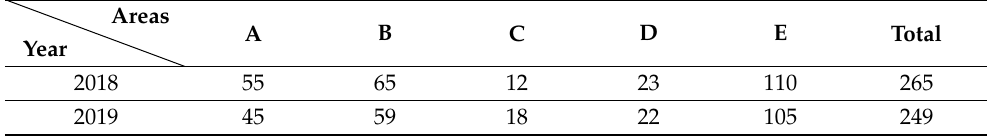
Table 1. Number of stations for water collection per area in the 2018 and 2019 field surveys. A B C D E Total